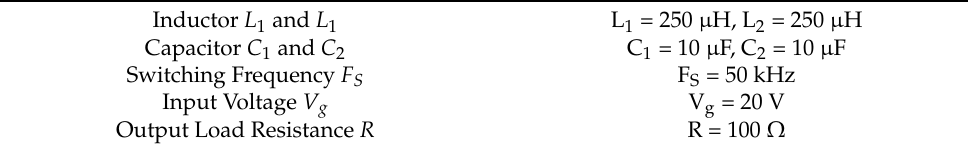
Figure 12. Schematic of the simulated converter. Table 2. Parameters.